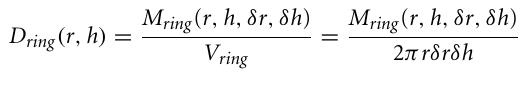
one of the boundaries, has a radius r (pointing to the center of the ring) and a thickness δ r . It can (C) be fully contained in the slice, (D) extend the slice on one of its sides, or (E,B) extend on both of its sides. (F) Effect of slicing of a neuron leaving a contiguous structure within the slice (dark blue), lost branches outside the slice (red) and orphan branches within the slice (light blue and marked in dashed ellipses). These orphan branches have lost their parent branches and therefore their connection to the dark blue contiguous